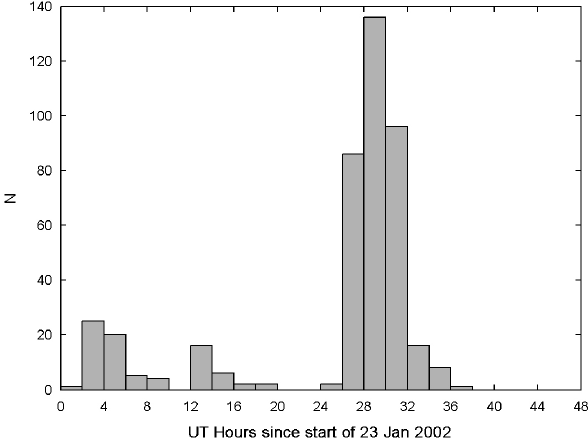
Fig. 4. Diurnal variation of the matching events detected by the Kattron and WWLL networks on 23–24 January